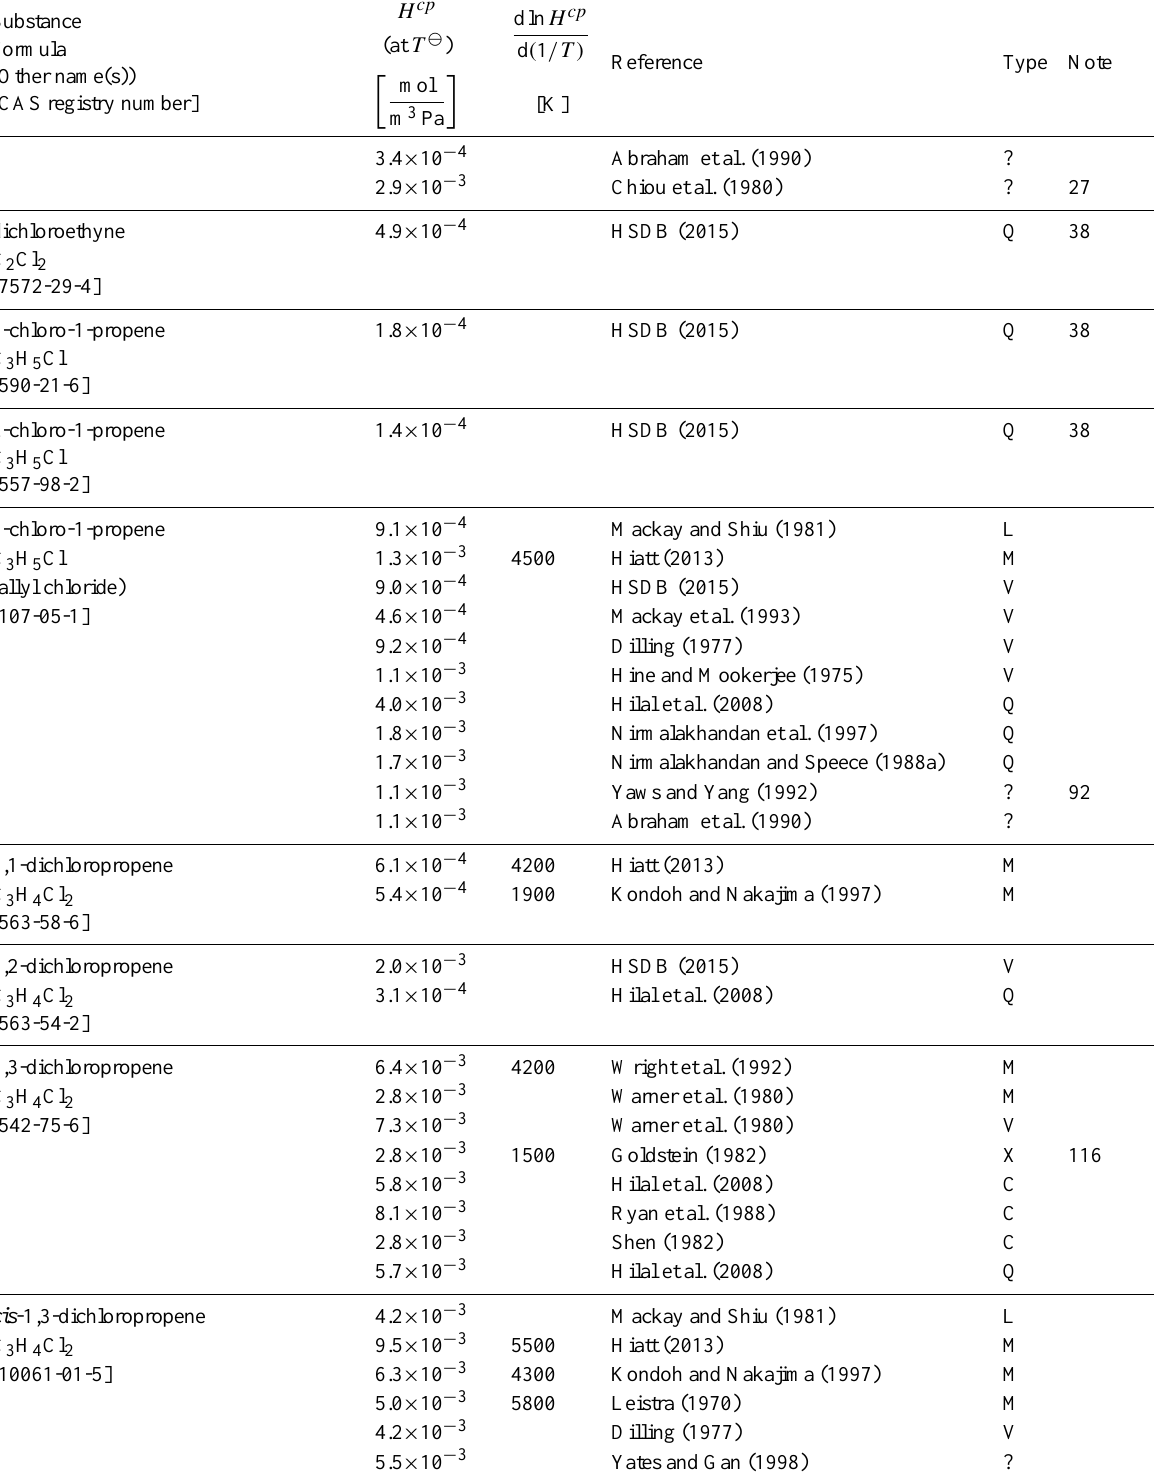
Table 6: Henry’s law constants for water as solvent